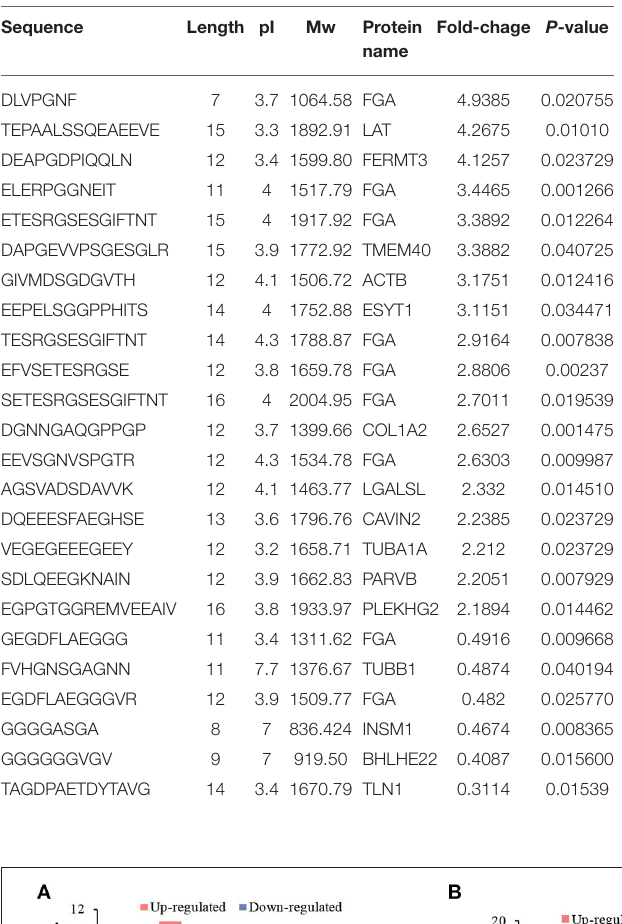
of the identified serum peptides, we found that the lengths of most peptides ranged from 8 to 18 amino acids ( Figure 1A ). In addition, the relationship between the molecular weight (Mw) and the isoelectric point (PI) was also investigated, and the most